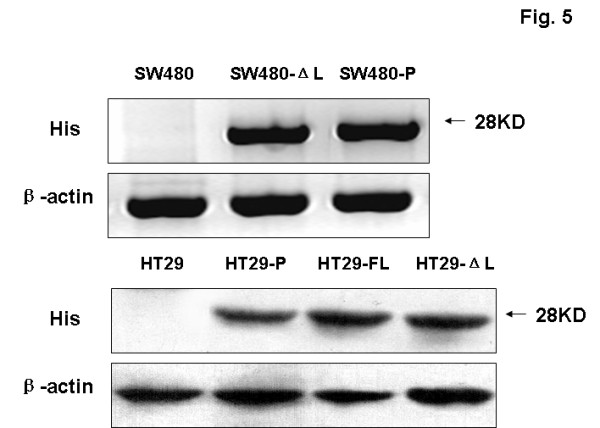
Expression of the His tag in the tumor cells. Cell lysates were prepared from different SW480 and HT29 sub-tumors. Western blotting analyses were performed to detect the protein levels of His tag, with β-actin as a reference control.